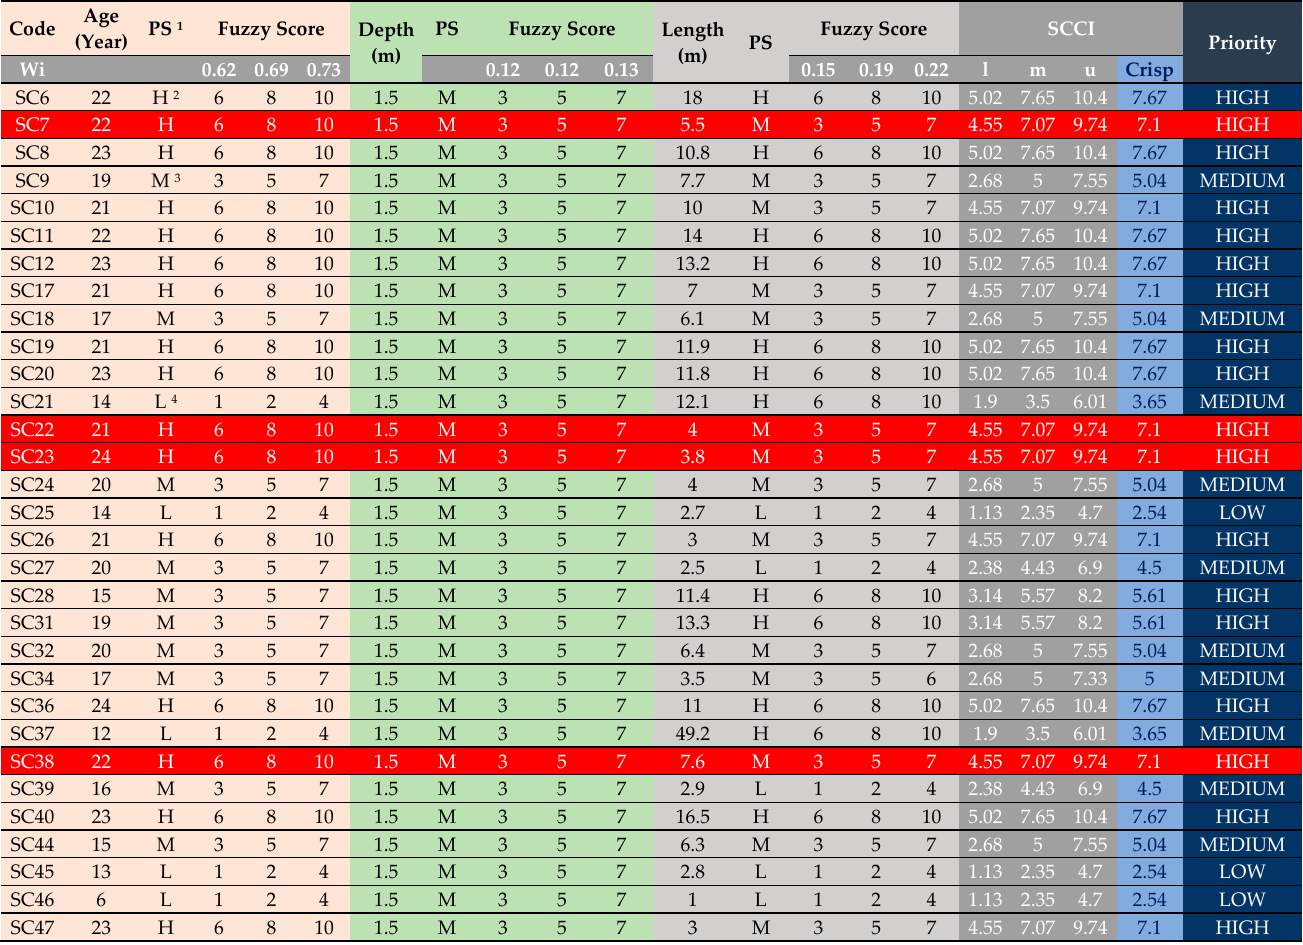
Table 5. Excel-based DSS results for service connection condition index (SCCI).